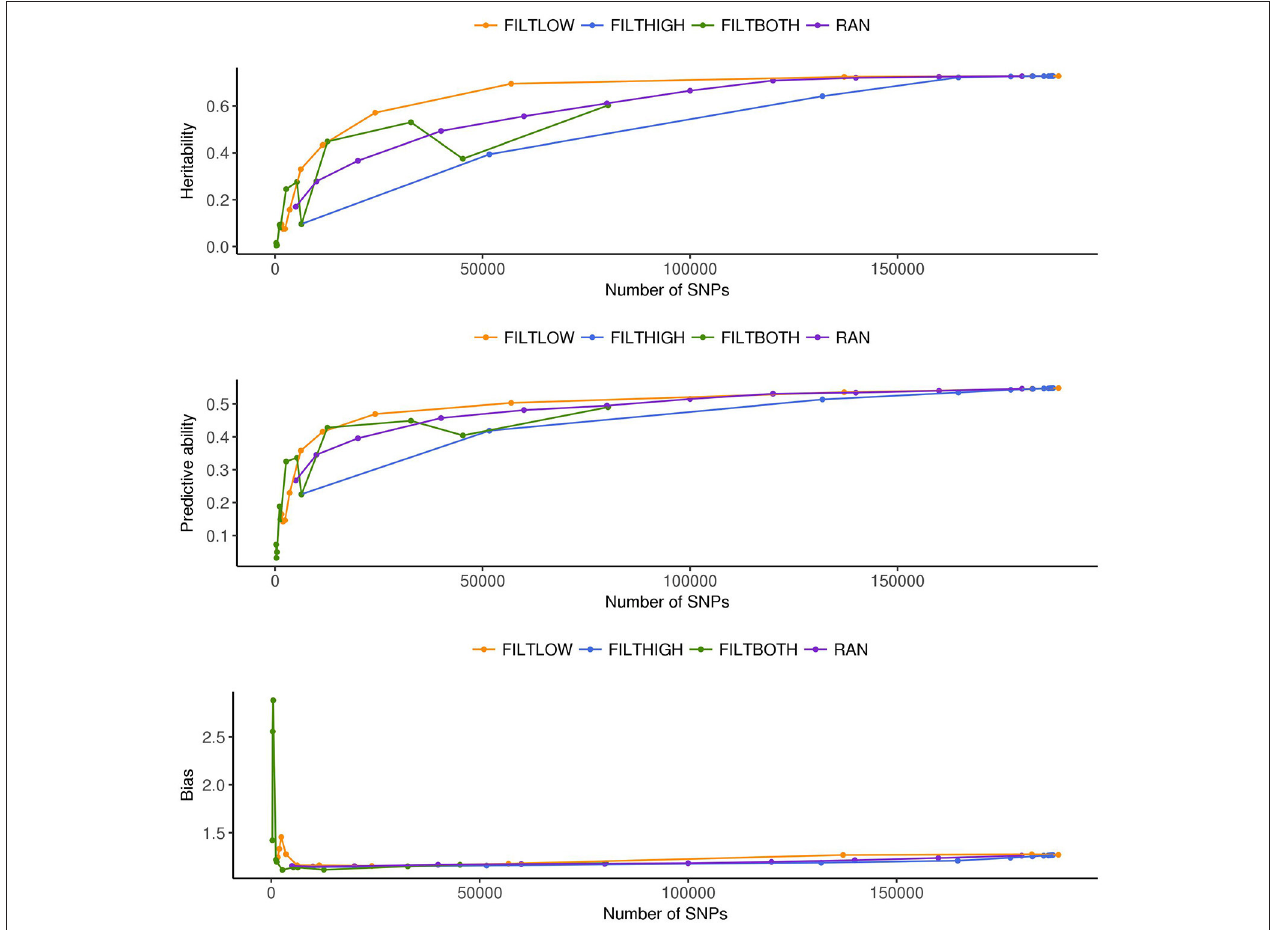
FIGURE 5 | Estimated heritability, predictive ability and bias in different SNP filtering scenarios 1 for rust resistance. 1 FILTLOW, strategy filtering out SNPs having low average depth; FILTHIGH, strategy filtering out SNPs having high average depth; FILTBOTH, strategy filtering out SNPs having both low average and high average depth; RAN, strategy keeping SNPs randomly with different data